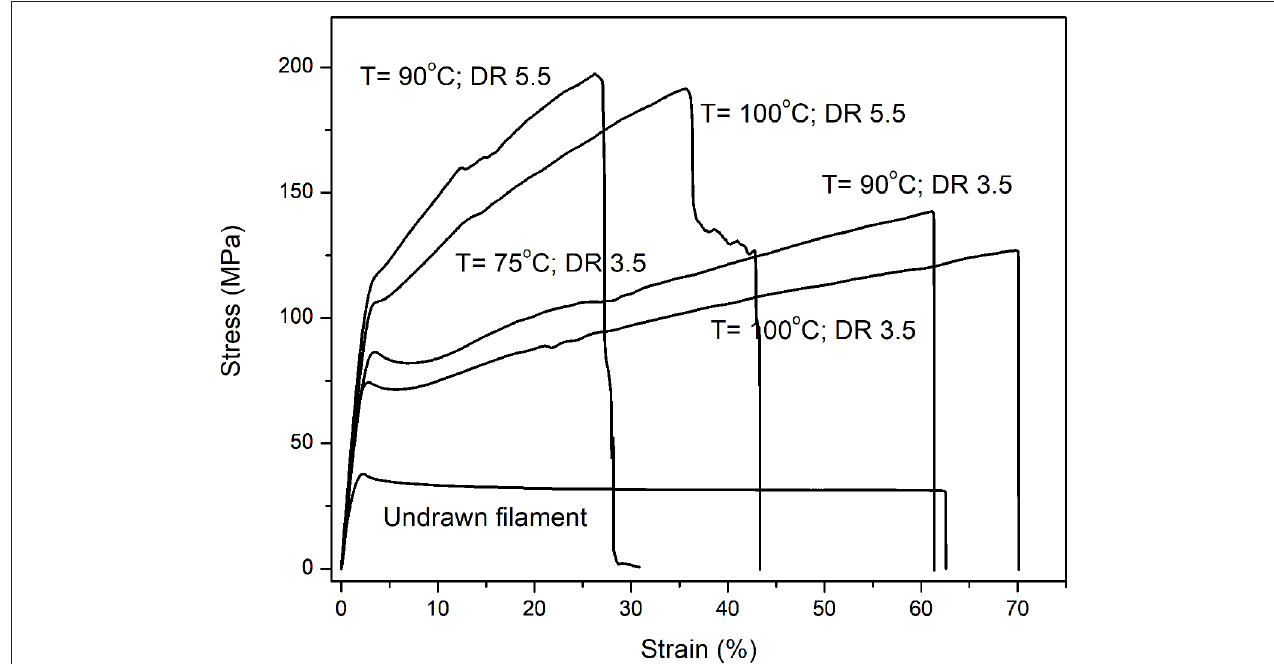
FIGURE 11 | Typical stress-strain curves for the Cu-filled PLA filaments drawn at different drawing conditions.